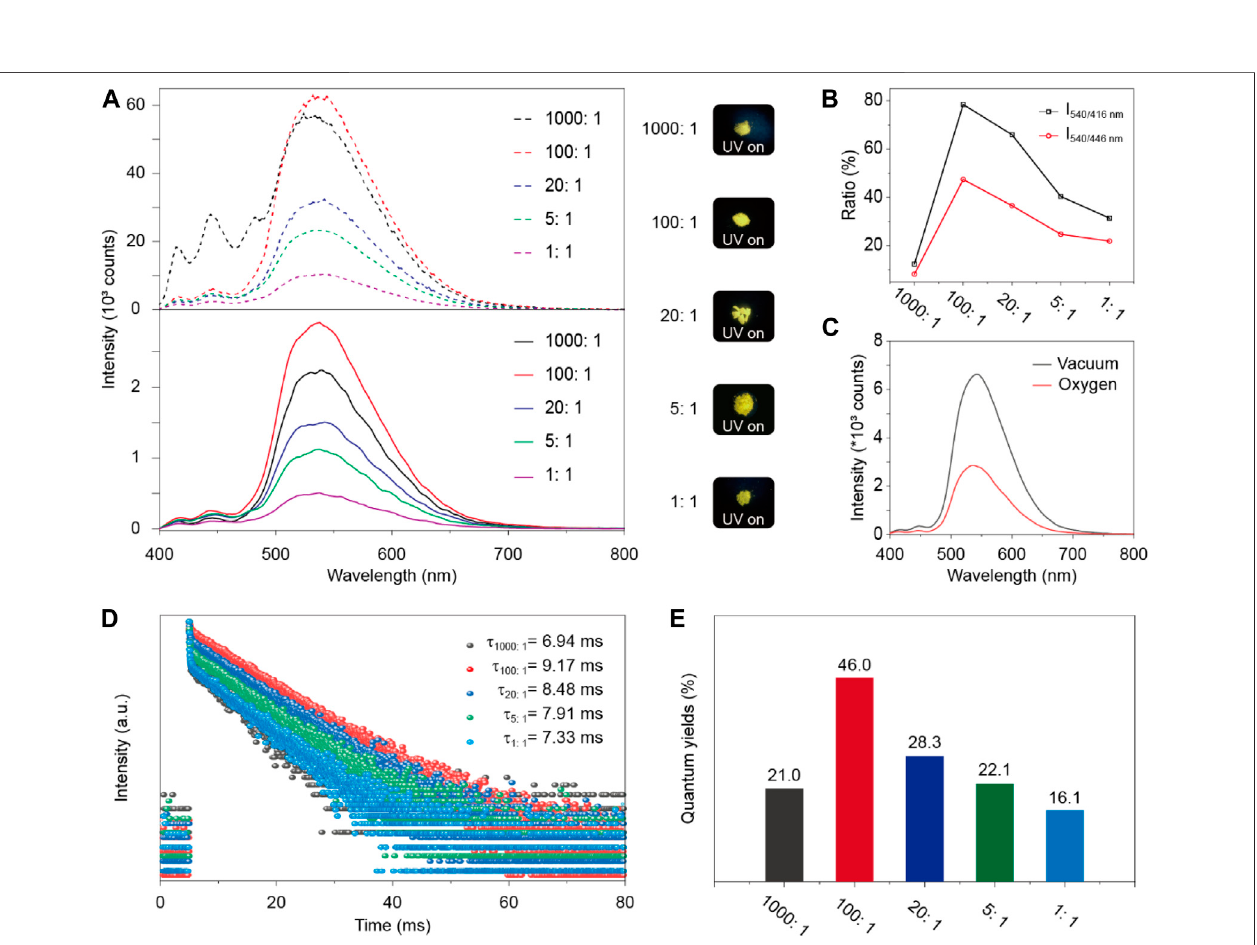
FIGURE 3 | (A) Steady-state PL (dotted line) and decay emission spectra (full line) of BPO/TTR-doped crystalline powders at different molar ratios excited by 390 nm. Insets show photographs under 365 nm UV light. (B) The ratio of phosphorescent intensity at 540 nm and fl uorescent intensity at 416 or 446 nm of the decay emission spectra in the BPO/TTR doping system with different doping ratios. (C) Phosphorescence spectra of BPO/TTR composite (100:1) under oxygen and vacuum atmosphere,respectively. (D) Lifetimepro fi lesofdecayemissionbandat540 nmfortheBPO/TTRcompositesexcitedby390 nm. (E) Phosphorescencequantum yields of BPO/TTR-doped materials with different molar ratios of guest (1000:1, 100:1, 20:1, 5:1 and 1:1 Mol %).